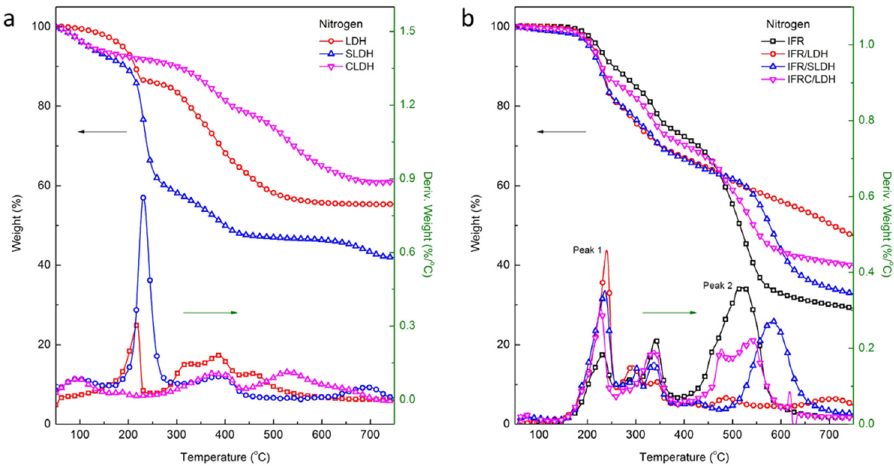
Figure 2. TG curves of ( a ) LDHs and ( b ) IFR/LDHs.